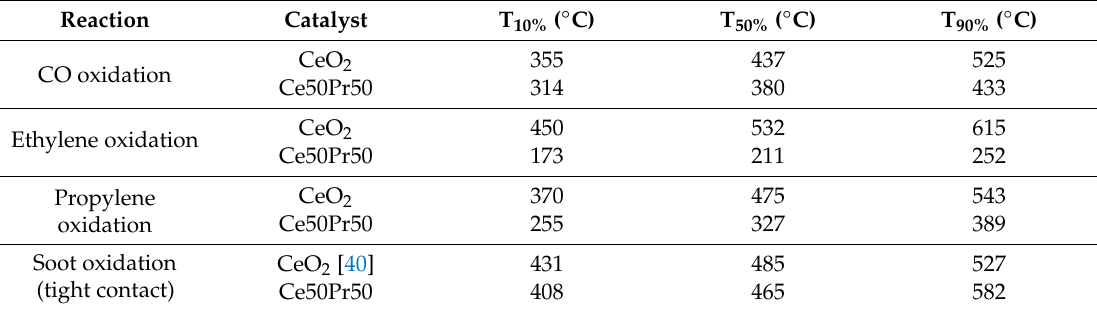
Table 2. Comparison of the parameters obtained from the different catalytic tests performed in low-oxygen conditions (1% O 2 ) over the Ce50Pr50 catalyst and pure CeO 2 . The temperatures at which 10%, 50% and 90% of conversion were reached (T 10% , T 50% and T 90% , respectively) are displayed.